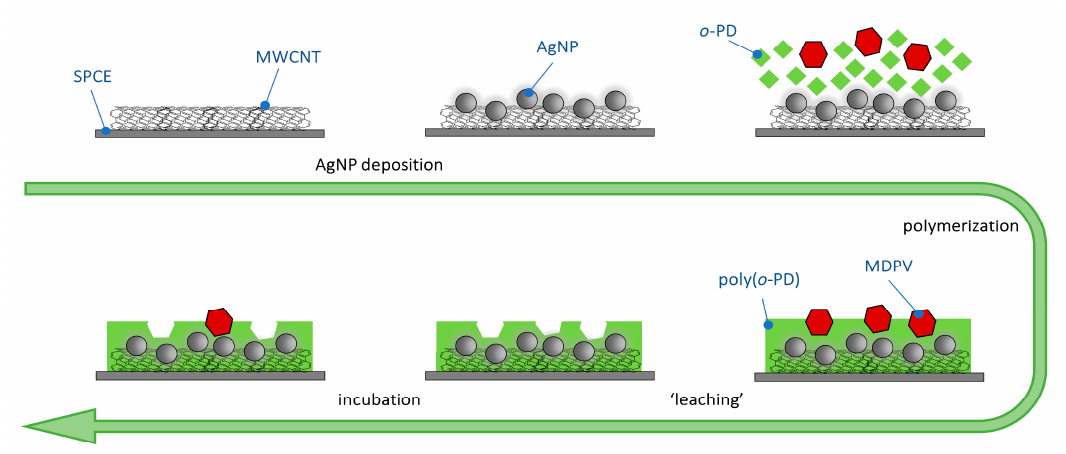
Figure 1. Schematics of the development of the SPCE-MWCNT-AgNP-MIP